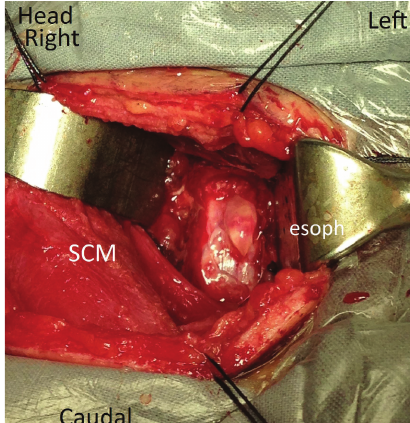
Figure 5: Intraoperative photograph after removal of the herniated disc fragment. Surgical approach was from the right side. The disc fragment has been removed. The near-intact arachnoid layer is seen as a bleb protruding through the dural tear. There is minimal cerebral spinal fluid leakage. SCM = sternocleidomastoid muscle. Esoph = trachea and esophagus deep to the retractor.